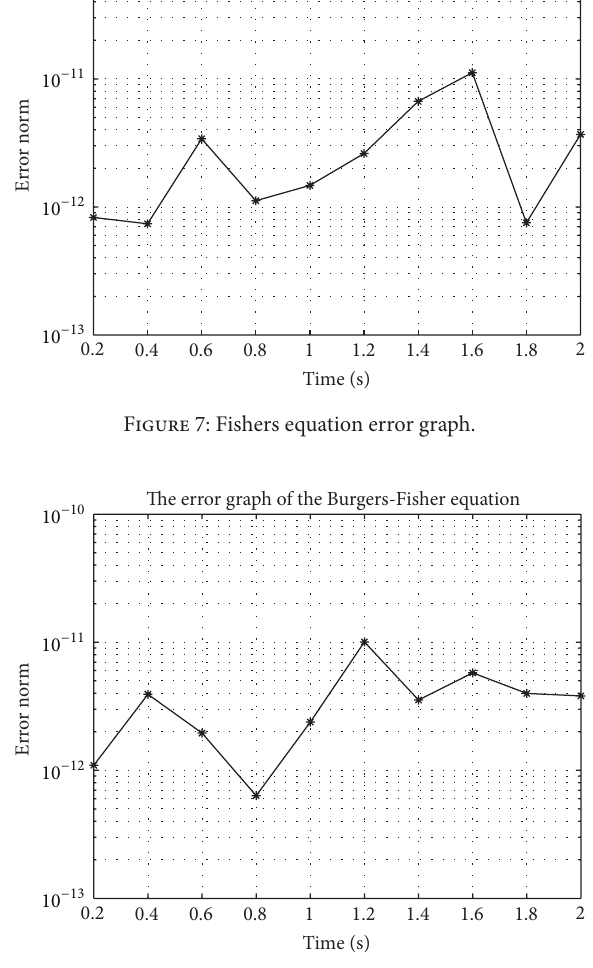
Figure 8: Burger-Fishers equation error graph.